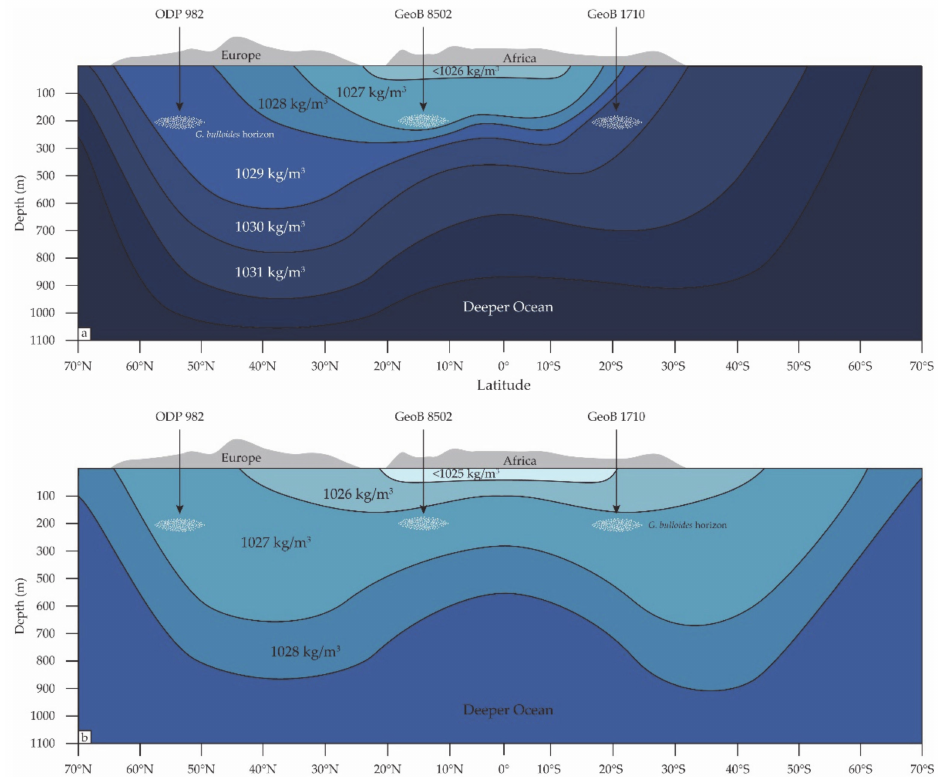
Figure 5. The hydrographic properties of water parcels are strongly influenced by the atmosphere through air–sea interaction and once subducted from the surface layer the density (temperature and salinity) of a water parcel is conserved and remains constant since mixing across isopycnal surfaces is generally much weaker than mixing on isopycnal surfaces [77]. In oceanic regions of normal salinity conditions, the latitudinal temperature changes determine the density of the subducted waters. ( a ) During extreme glacial conditions, such as the LGM, enhanced atmospheric thermal gradients increase the number of seawater subduction zones that lead to enhanced oceanic density gradients (Figure 3) and thus more vigorous oceanic circulation; ( b ) during deglacial times of relaxed thermal gradients, surface ocean stratification prevails that can lead to the cessation of the oceanic circulation (SMCEs). Note the density difference between the glacial and interglacial ocean, which can be up to ~3.5 kg/m 3 [78] due to ice cap buildup. However, the seawater density of tropical regions under the influence of the ITCZ is expected to be stable with perhaps only small glacial/interglacial